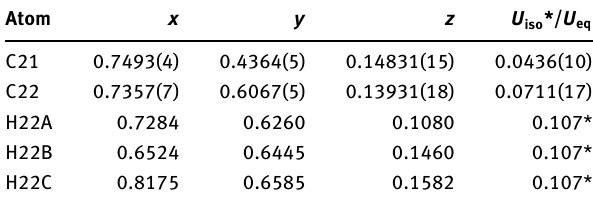
Table 2: Fractional atomic coordinates and isotropic or equivalent isotropic displacement parameters (Å 2